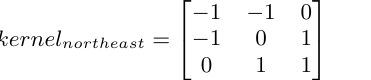
Figure 3: Distance image of the projected point cloud from the TU-Dresden’s H¨ulssebau. Distances belong from 3D points to the projection